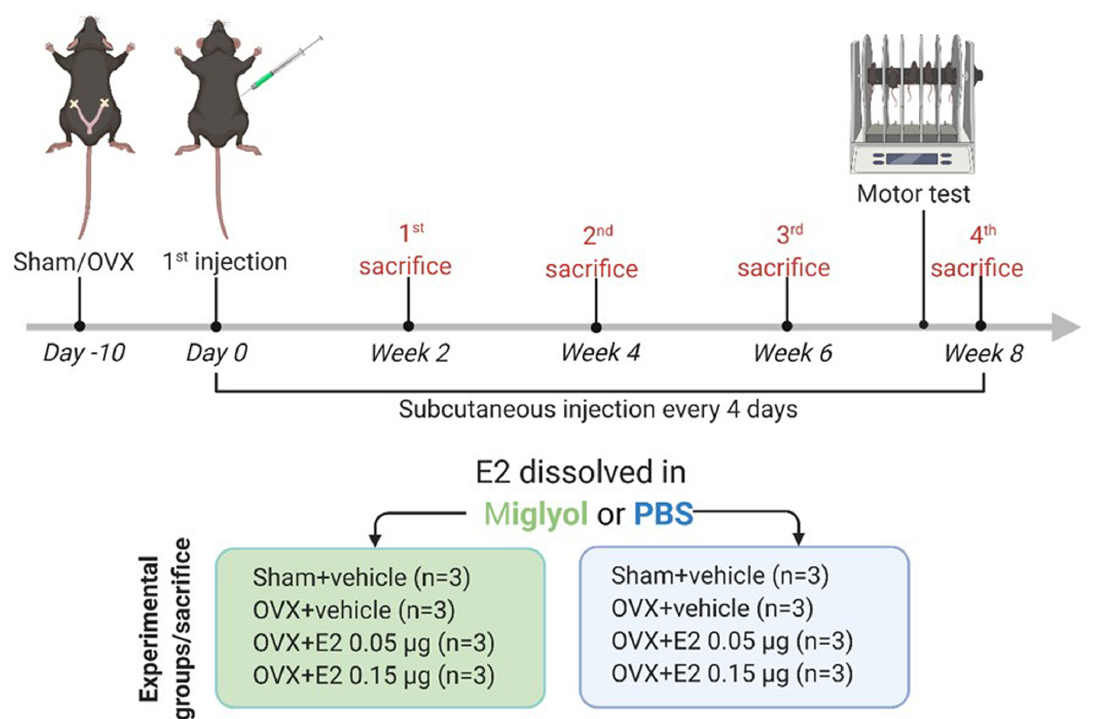
Figure 1. Schematic description of the experimental plan. This figure describes the timeline of the experiments and the experimental groups included in the study.